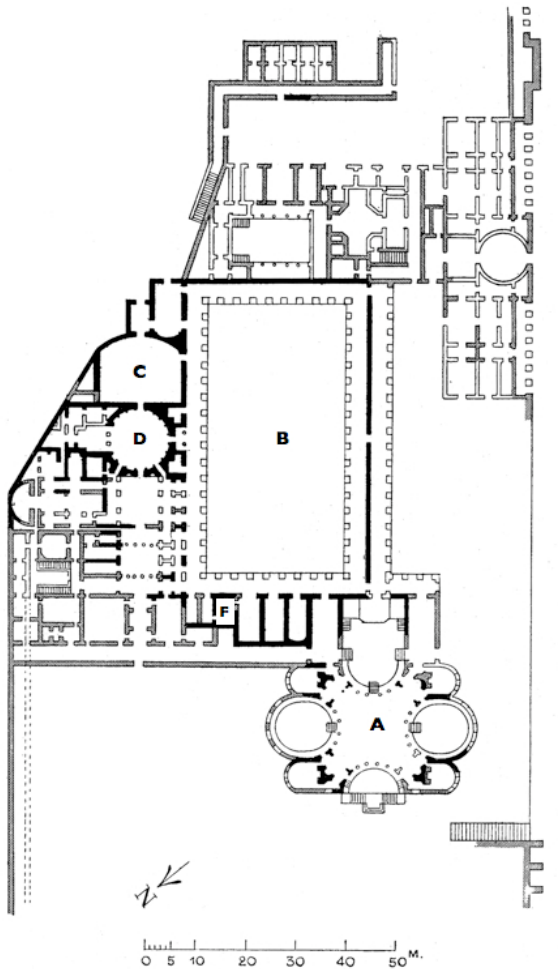
Fig. 2. Plan of the Accademia: (A) Belvedere ; (B) inner porch; (C) : so called Zooteca ; (D) : Apollo’s Temple ; (F) : stair descending to the subterranean tunnels (from Winnefeld,